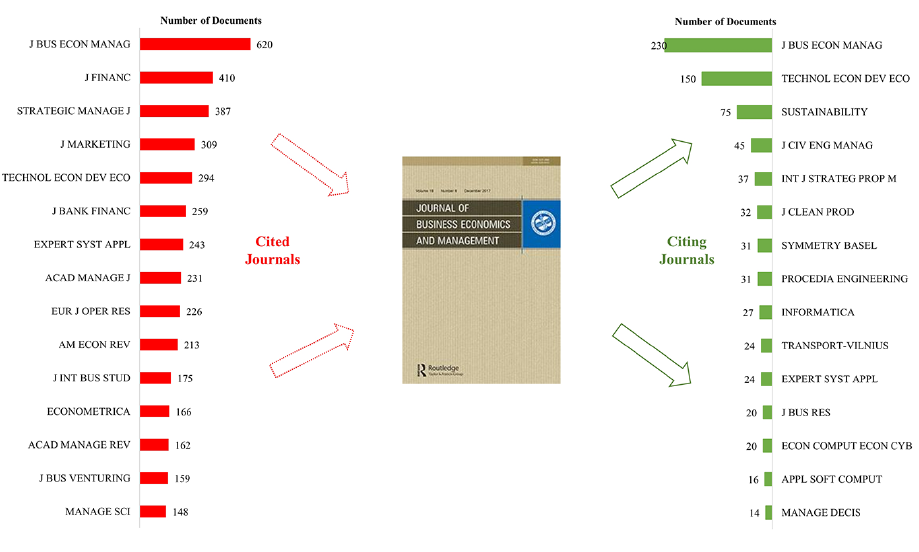
Figure 2. Knowledge Flow between JBEM and other